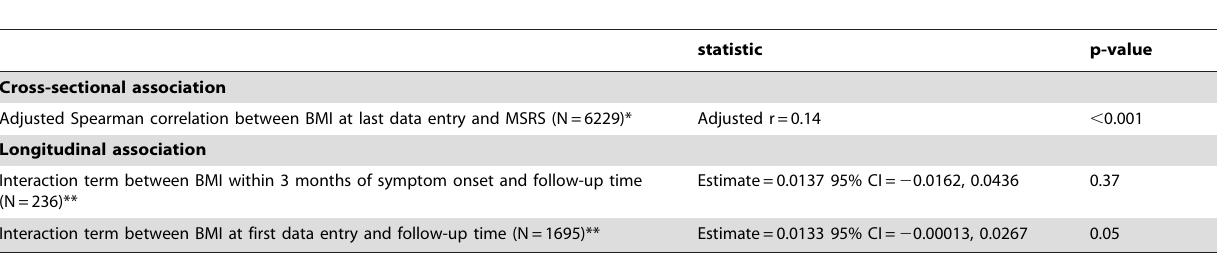
Table 4. Cross-sectional and longitudinal associations of BMI with disease severity, as measured by the MSRS.